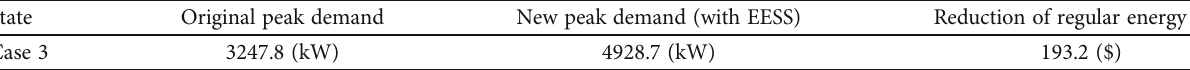
Figure 8: Power of EESS. Table 6: Case 3